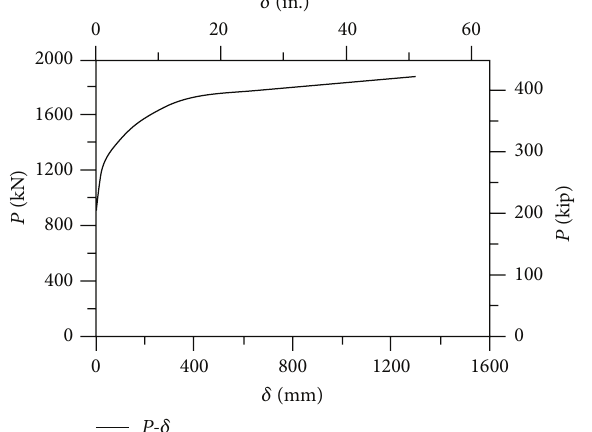
Figure 13: Load-displacement numerical curve.